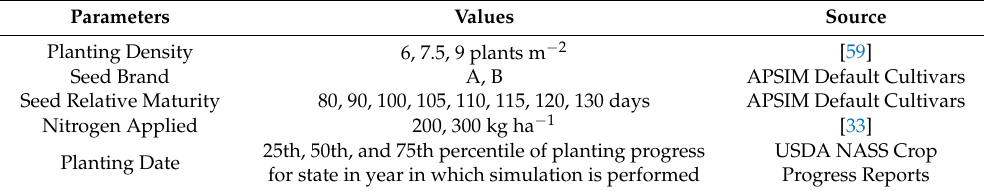
Table 2. Possible parameter values considered in APSIM